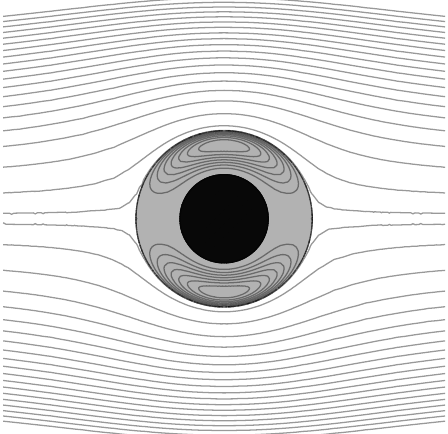
Figure 4. Streamlines in the symmetry plane for the flow field of a uniform flow past a fluid-coated rigid-kernel sphere. The black region is the rigid kernel and the gray region with circulation is the fluid coating. The viscosity ratio is ¯ µ / µ = 5. The radius of the rigid kernel and the thickness of the fluid coating are set as a = d =